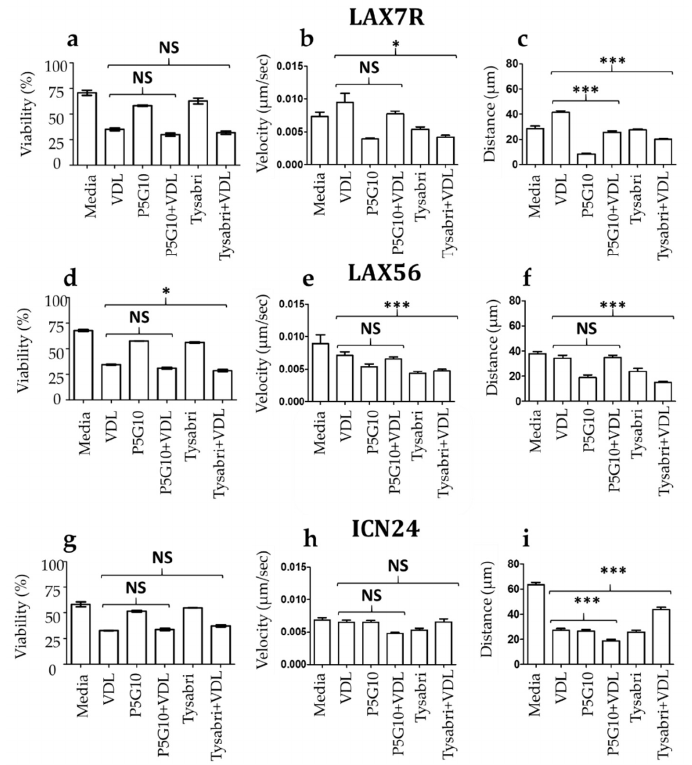
Figure 4. The effects of integrin blockade on the velocity and migration distance of primary B-ALL cells. B-ALL cells LAX7R ( a – c ), LAX56 ( d – f ), and ICN24 ( g – i ) were treated with VDL (VDL) or without VDL (Medium) along with P5G10 or Tysabri for 7 days. After a washing and medium incubation period of 12 h, ALL cells were time-lapse imaged for 12 h ( a , d , g ). Cell viability was measured by 7- AAD/Annexin V staining using flow cytometry ( b , e , h ). The velocities and ( c , f , i ) migratory distances